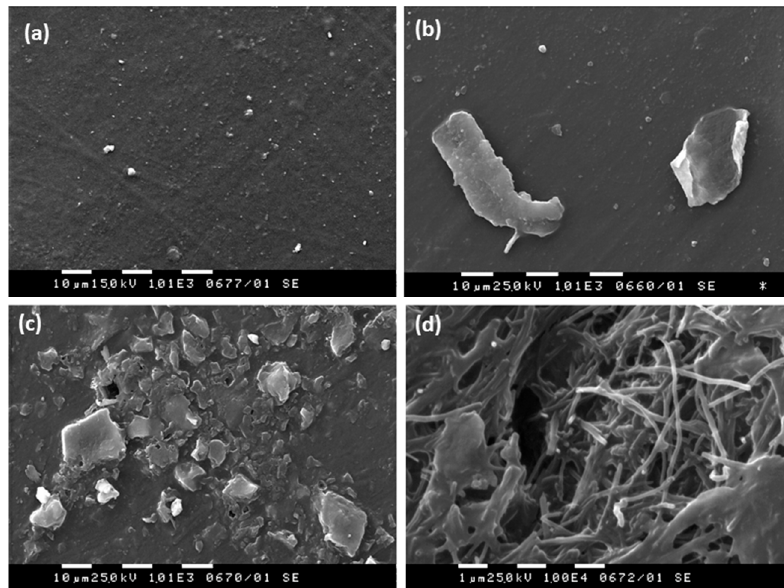
Figure 2. Scanning electron microscope (SEM) micrographs of the film surfaces: ( a ) reference GNP/MWCNT/PLA film before the test; ( b ) after the ultra-strong dynamic test in 10% ethanol, ( c , d ) after the ultra-strong dynamic test in 50% ethanol (in different places).